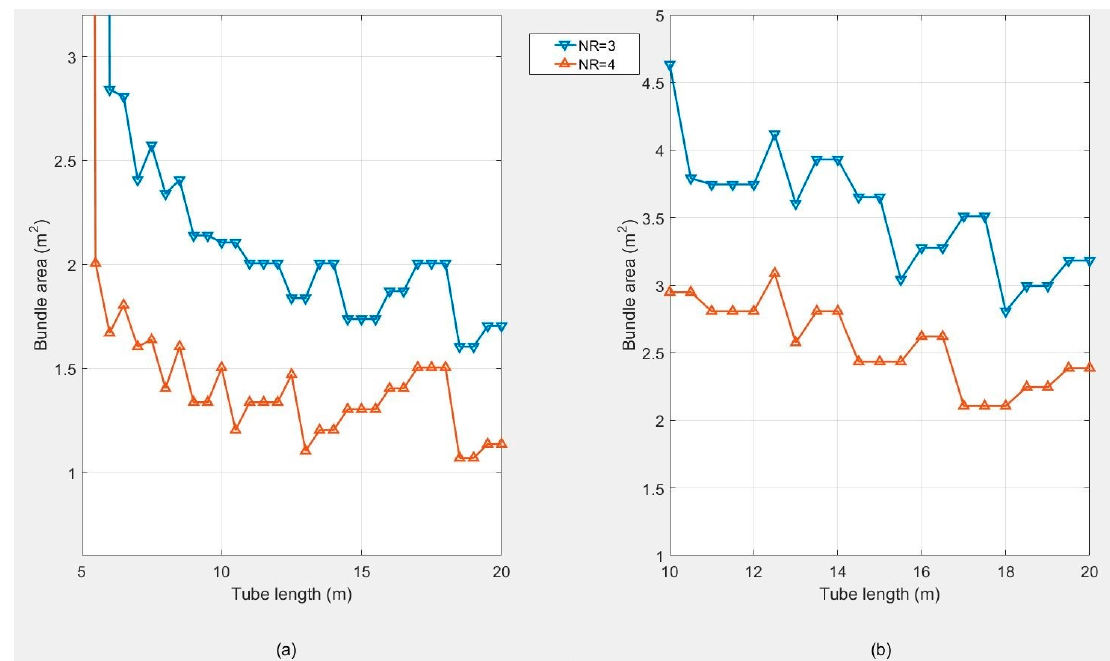
Figure 7. Bundle area vs. tube length for 3 and 4 number of rows ( a ) outside diameter of 7.35 mm; and ( b ) outside diameter of 18.5 mm.